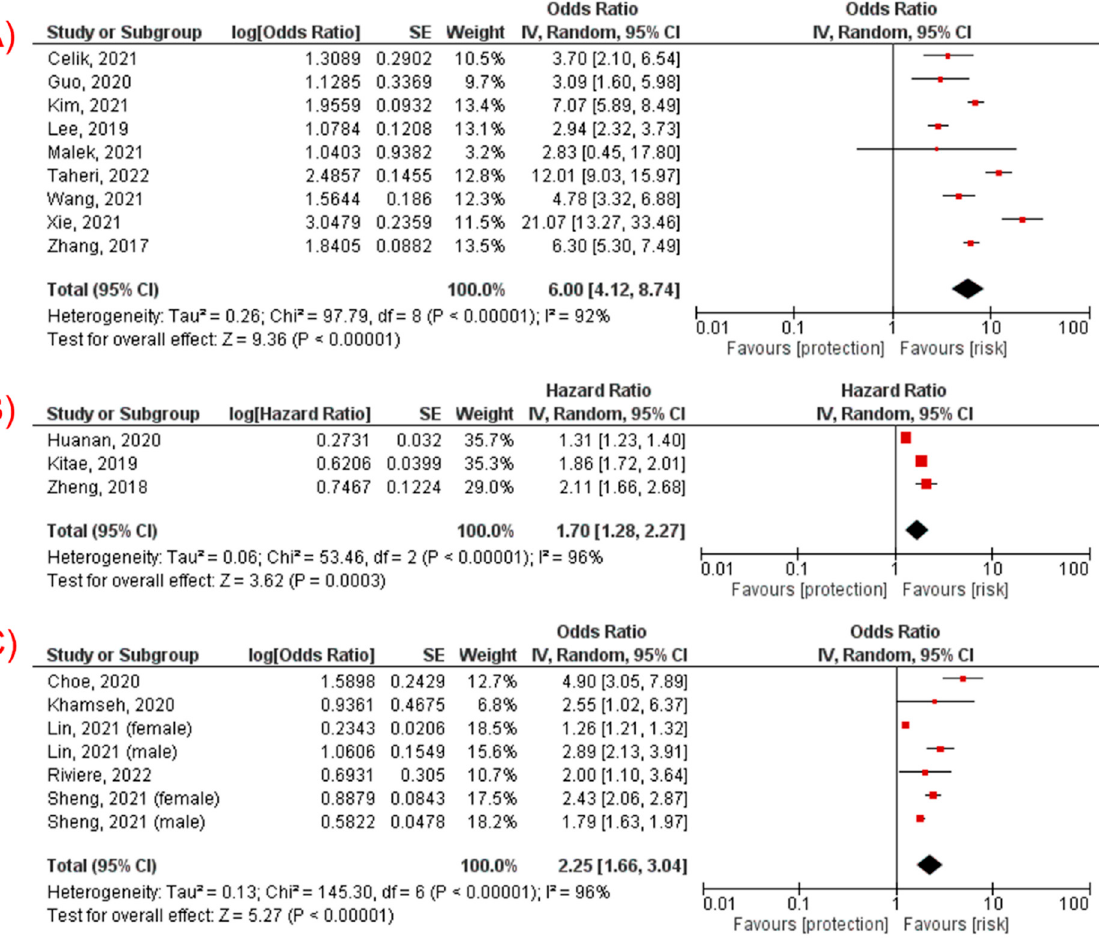
Figure 2. ( A ) Forest plot evaluating association between TyG index (analyzed as a categorical variable and presented as OR) and NAFLD [10,11,14,15,21,23,26,28,29]; ( B ) forest plot evaluating association between TyG index (analyzed as a categorical variable and presented as HR) and NAFLD [13,24,30]; ( C ) forest plot evaluating association between TyG index (analyzed as a continuous variable and presented as OR) and NAFLD [12,22,25,27,31].